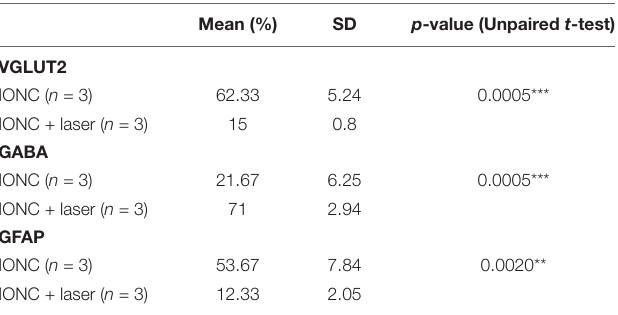
TABLE 1 | Quantification of VGLUT2, GABA, and GFAP expression in immunofluorescence